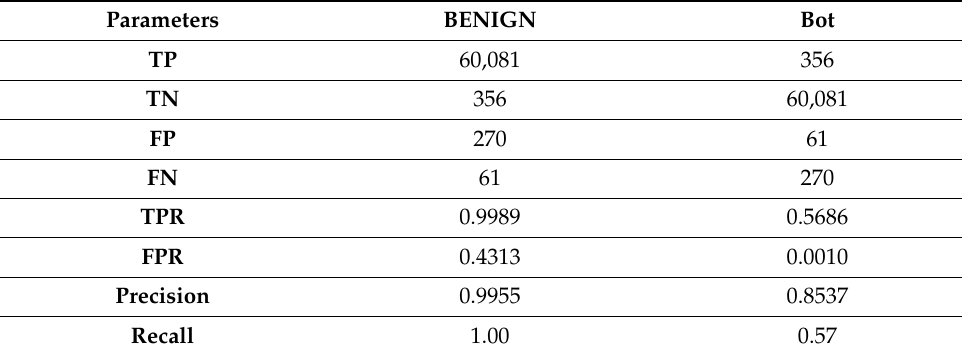
Table 8. Statistical report of Friday morning test